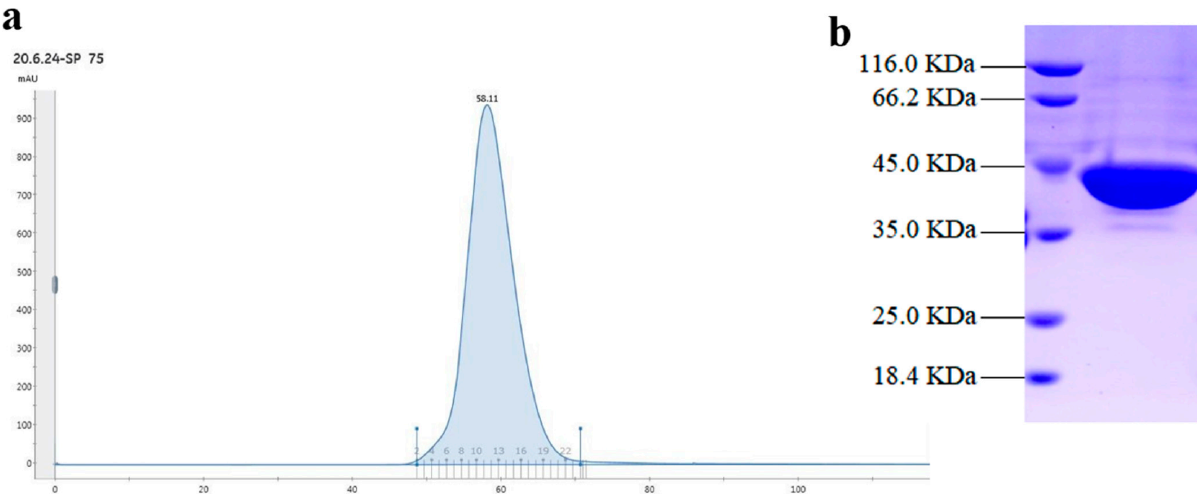
Figure 3. Gel filtration chromatography ( a ) and sodium dodecyl sulphate-polyacrylamide gel electrophoresis (SDS-PAGE) analysis of the purified SpPLD ( b ).